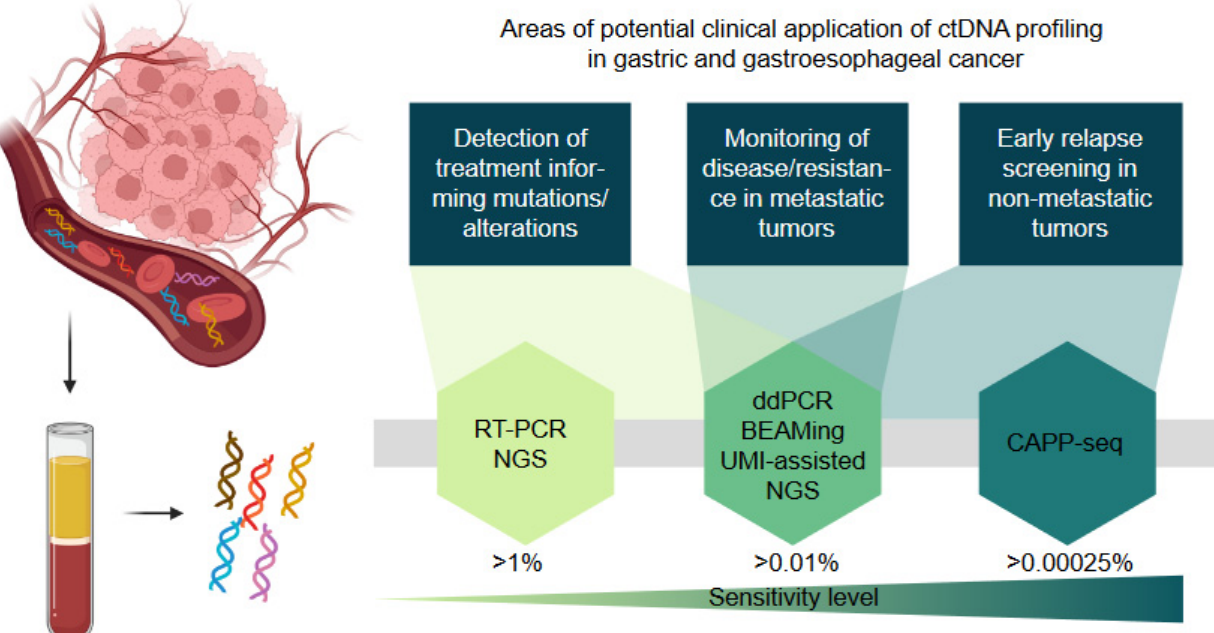
Figure 1. Schematic presentation of the potential applications of cfDNA profiling in gastric and gastroesophageal cancer. The sensitivity level indicates the minimal allele frequency (%) of a mutation that can be detected with the respective method. RT-PCR = real-time PCR; NGS = next-generation sequencing; ddPCR = digital droplet PCR; BEAMing = beads, emulsion, amplification, magnetics digital PCR technique; UMI = unique molecular identifier, CAPP-seq = cancer personalized profiling by deep sequencing.